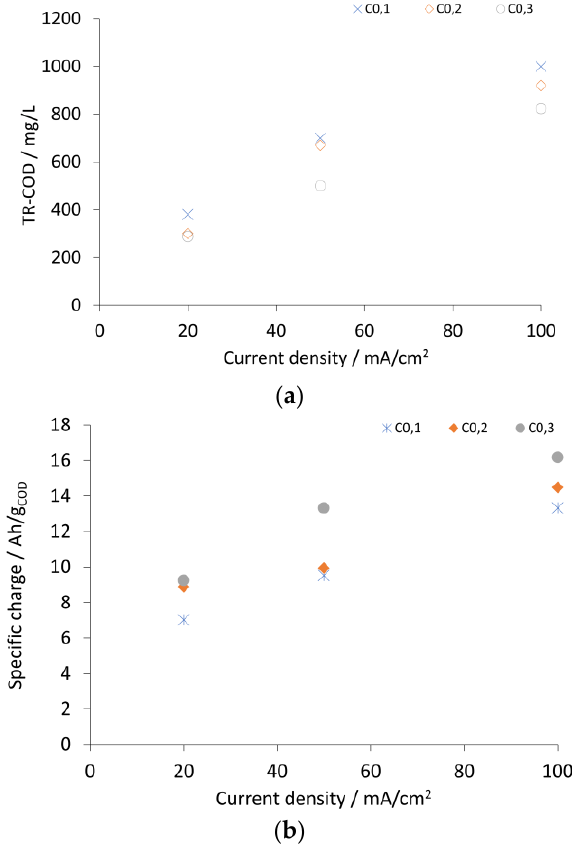
Figure 2 . Influence of different COD int. (C 0,1 = 4410 ± 17 mg/L; C 0,2 = 2267 ± 99 mg/L; C 0,3 = 1175 ± 13 mg/L) on: ( a ) total removed COD (TR-COD) and ( b ) specific charge demand (SCD); at different current densities (20, 50, and 100 mA/cm 2 ) after 4 h treatment.